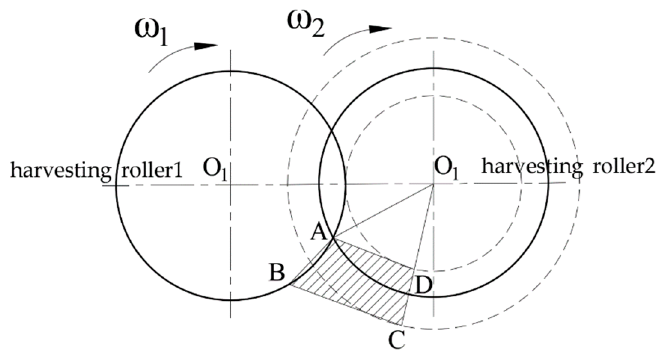
Figure 6. Position analysis of a peanut plant.